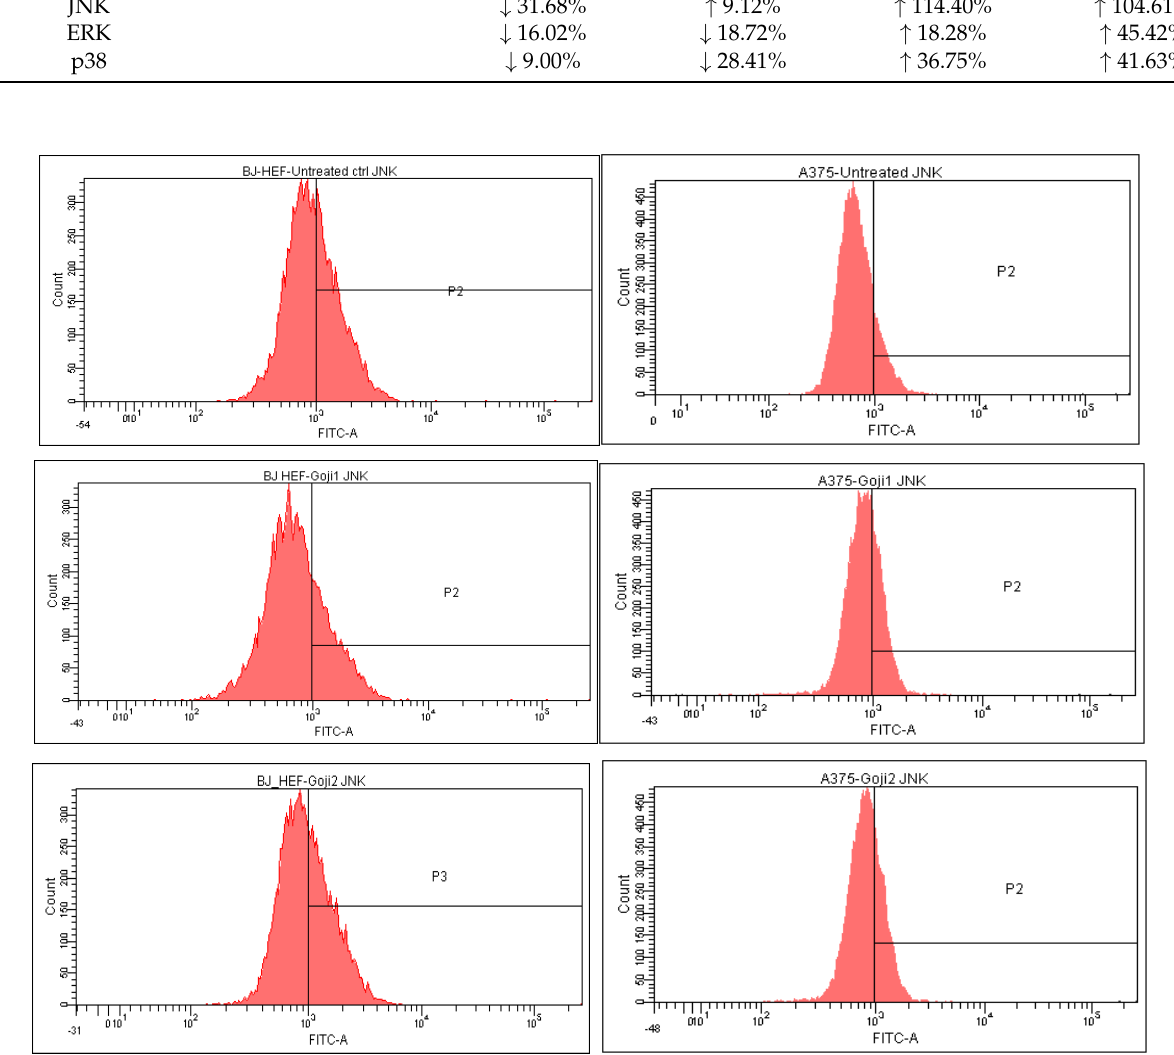
Table 4. The influence of zeaxanthin-rich Goji extracts 1 and 2 on phosphorilated mitogen activated protein (MAP) kinases-driven ROS signaling upregulation (depicted as ↑ ) or downregulation (de- picted as ↓ ) in normal and malignant cells in vitro.